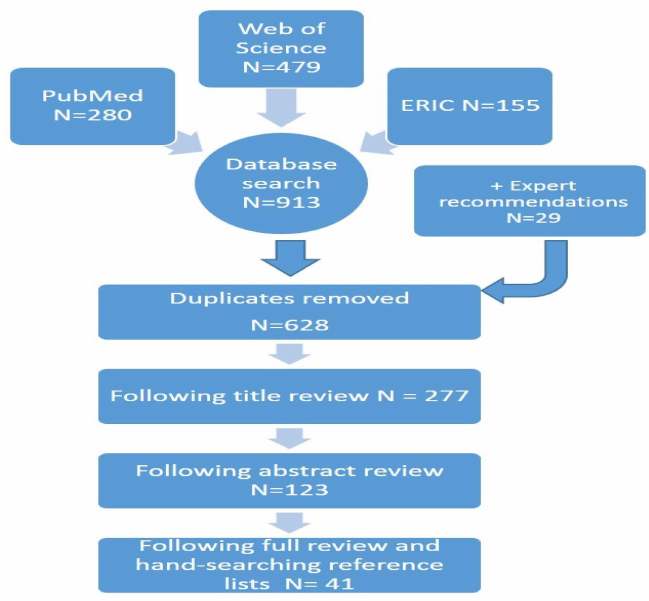
Figure 1. Scoping review flow